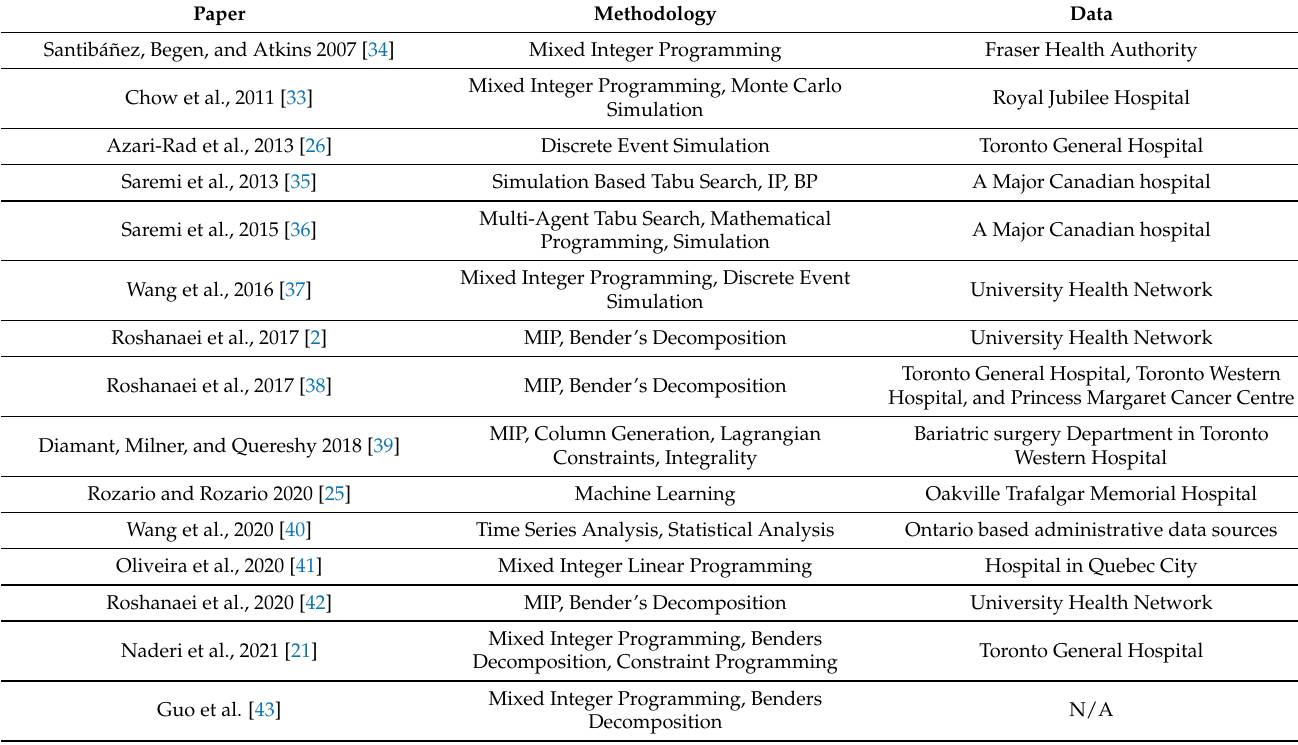
Table 4. Operating Room